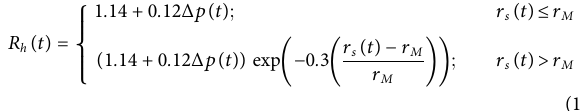
Frontiers in Built Environment |